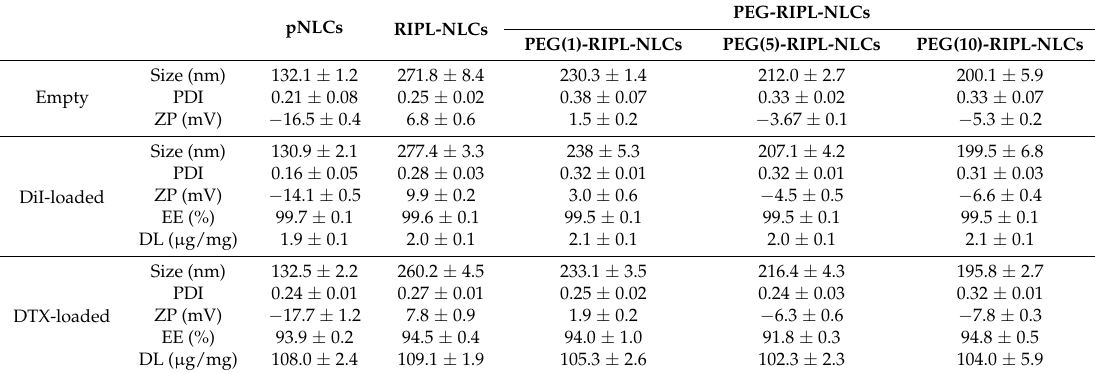
Table 1. Physicochemical characteristics of